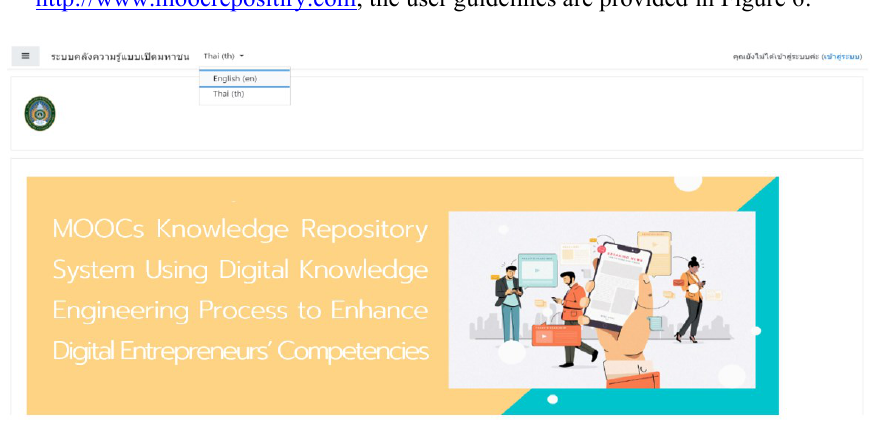
Fig. 6. MOOCs knowledge repository system at Home Page